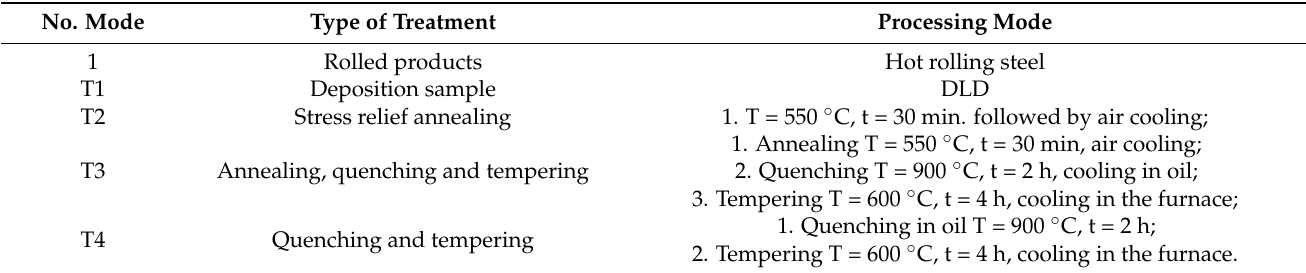
Table 2. Heat treatment modes of samples.